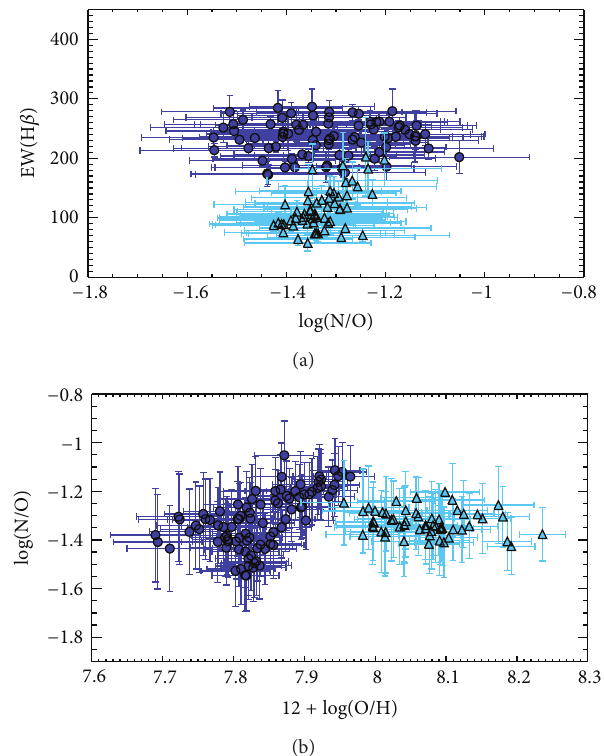
Figure 5: (a) Log (N/O) ratio versus EW(H 𝛽 ). (b) 12 + log(O/H) ratio versus log(N/O). Triangles correspond to the data points of Tol 0104-388andcirclescorrespondwiththedatapointsofTol2146-391. More details in